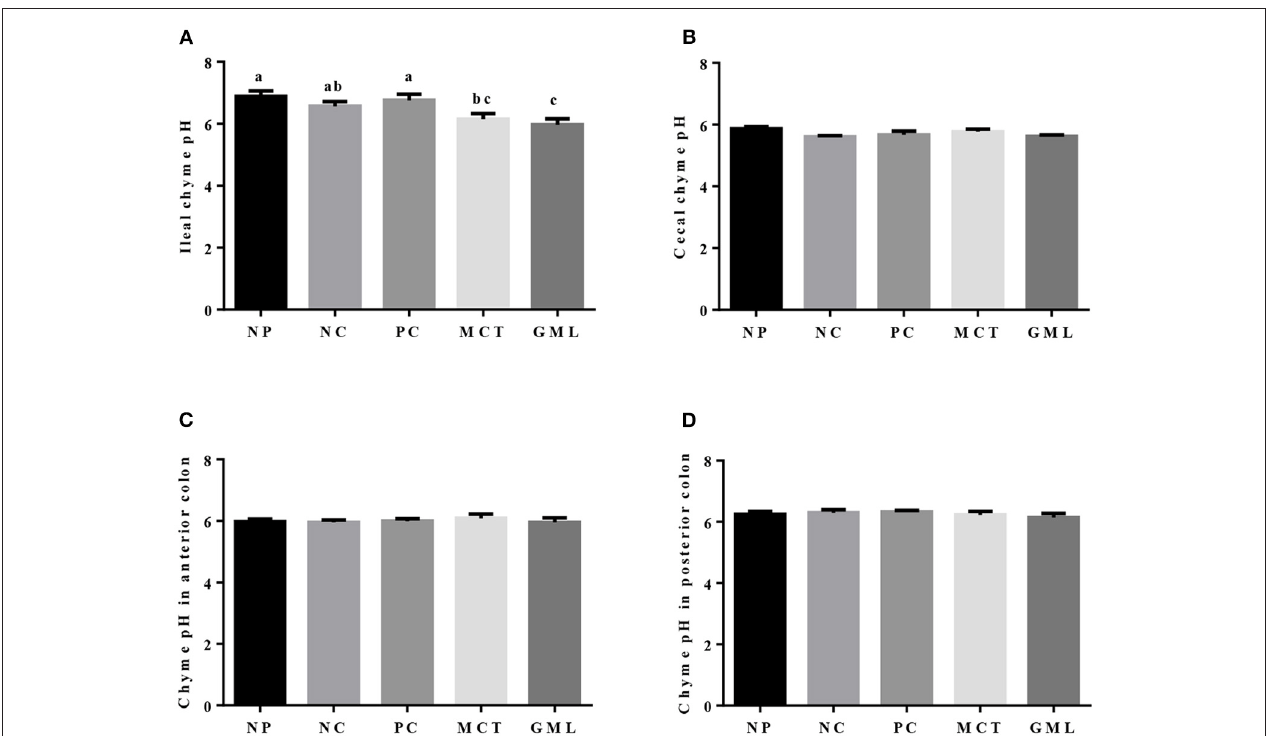
FIGURE 1 | The pH in the chyme of ileum (A) , cecum (B) , anterior colon (C) and posterior colon (D) . a − c Mean values sharing different superscripts within a row differ ( P < 0.05). Values are the mean ± SEM, n = 6. NP, normal protein basal diet no antibiotics included; NC, low-protein basal diet no antibiotics included;